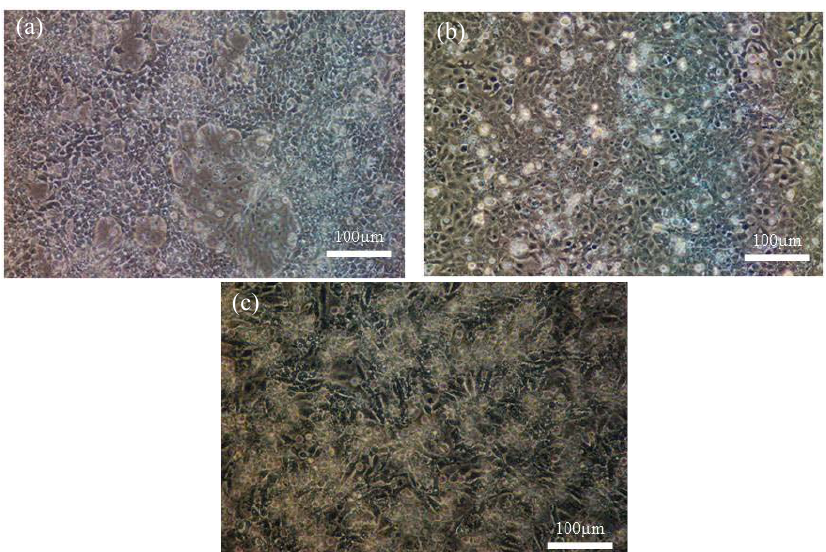
Fig. 2 Phase-contrast images of each cell layer. After 7 days, EC covered the surface of collagen gel layer. (a) bottom layer, HC; (b) middle layer, HSC; (c) top layer, EC.